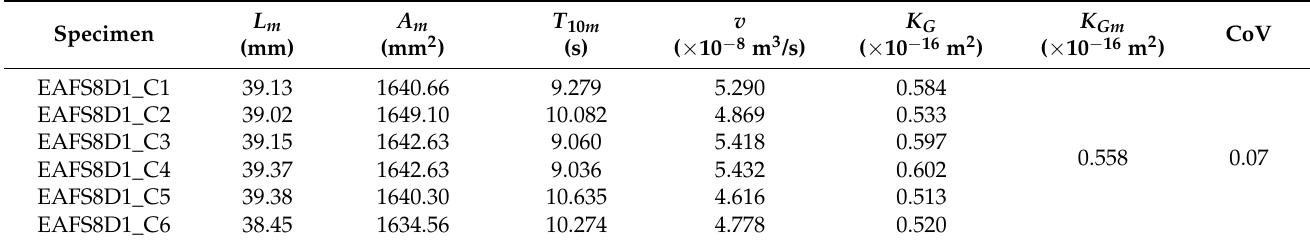
Table 16. Results of air permeability obtained for EAFS8D1 mixture.